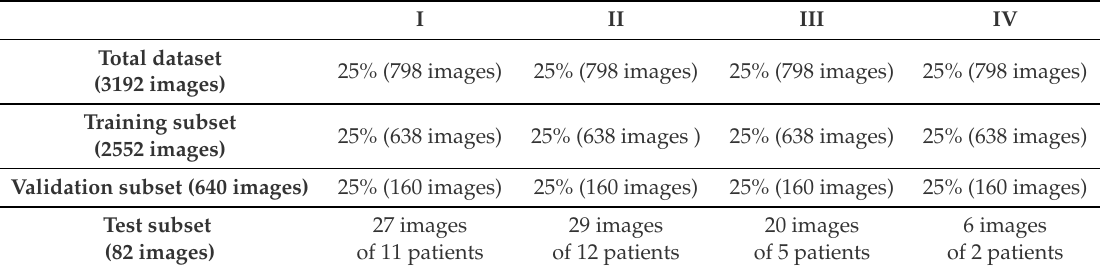
Table 5. Distribution of densities across balanced INbreast dataset (after